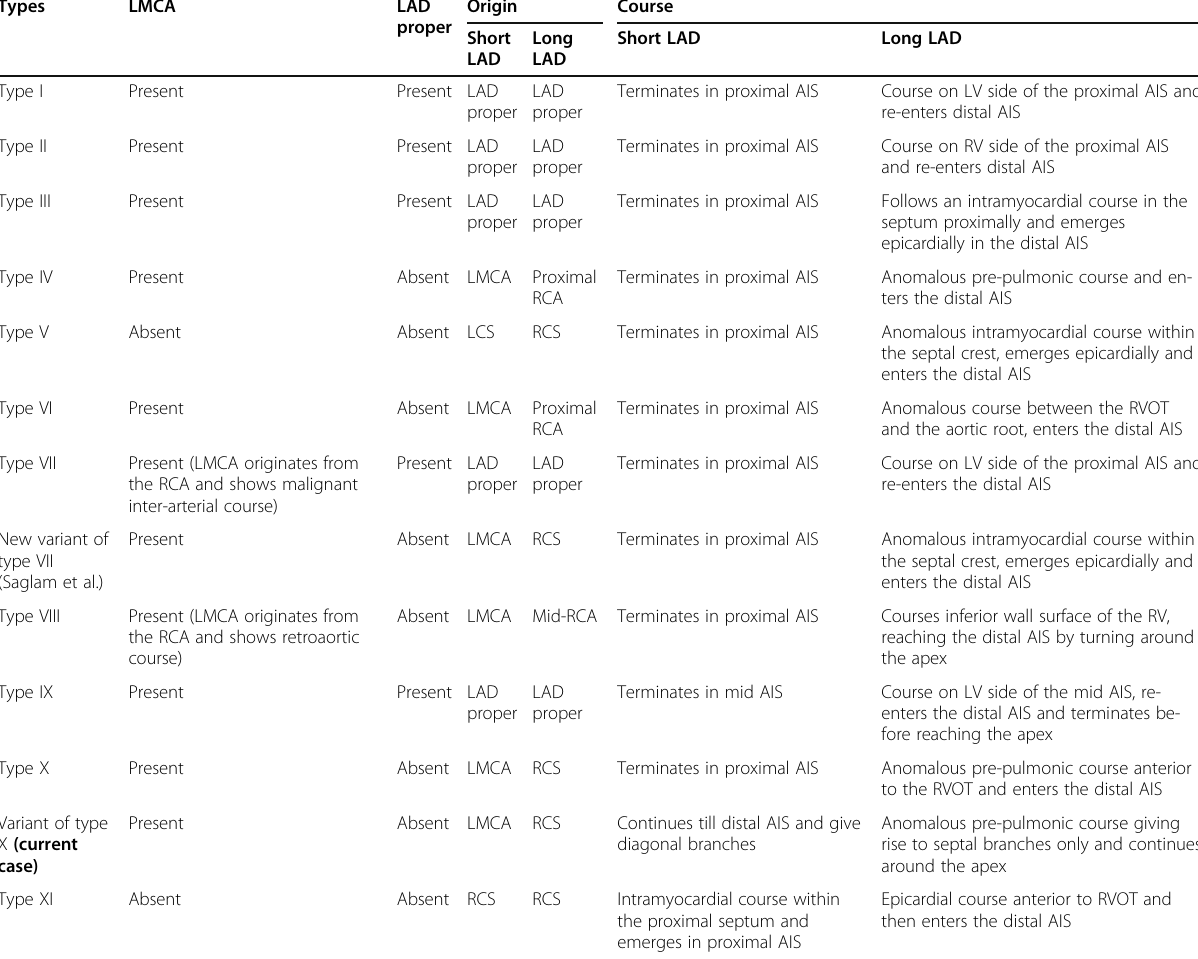
Table 1 Classification of dual LAD coronary anomaly (adapted from references [2, 4, 5, 7 –